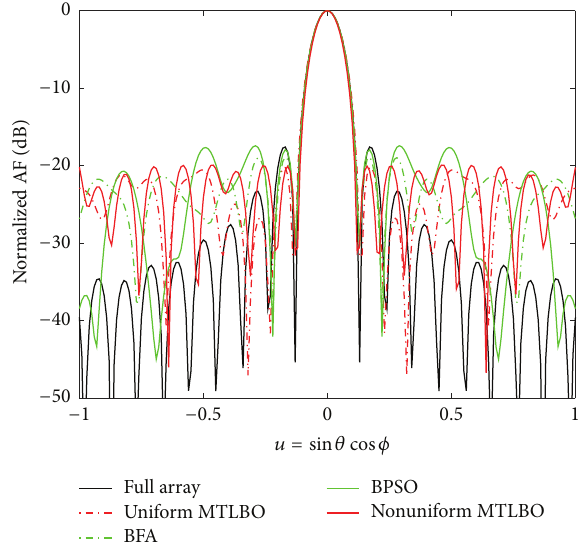
Figure 5: Comparison of array factors in the phi = 0 ∘ plane with FNBW = 0.13.